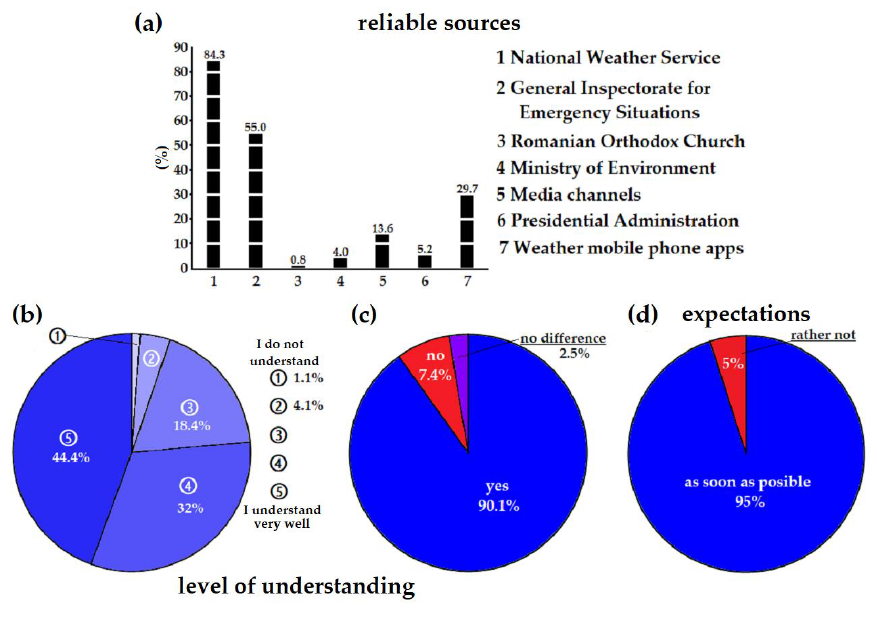
Figure A2. The summary results of questions Q6 to Q9 on: the reliable information sources ( a ), understanding level of weather apps ( b ), understanding level of weather service messages ( c ), and peoples’ expectations regarding the warning messages ( d )